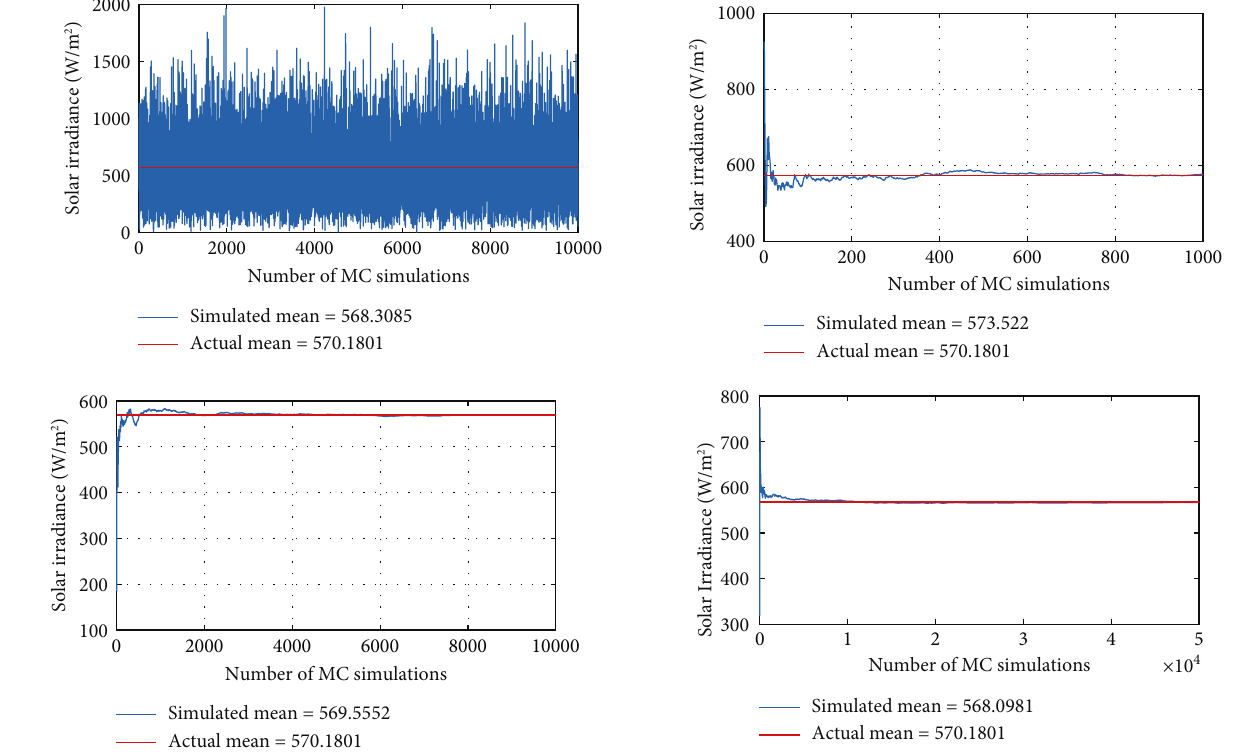
Figure 15: Simulation of solar irradiance with Monte Carlo simulations.